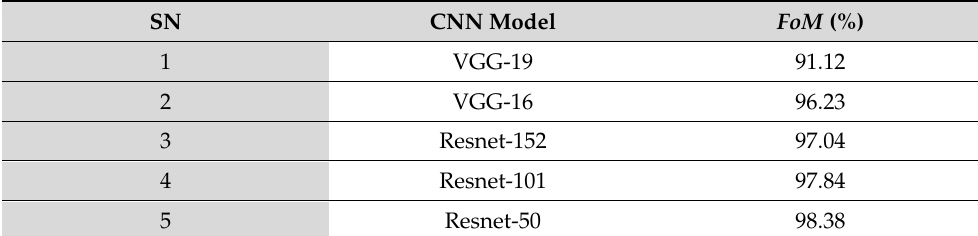
Figure 16. ROC curves for the performance analysis of CNN models. Table 5. FoM was observed for the CNN models.